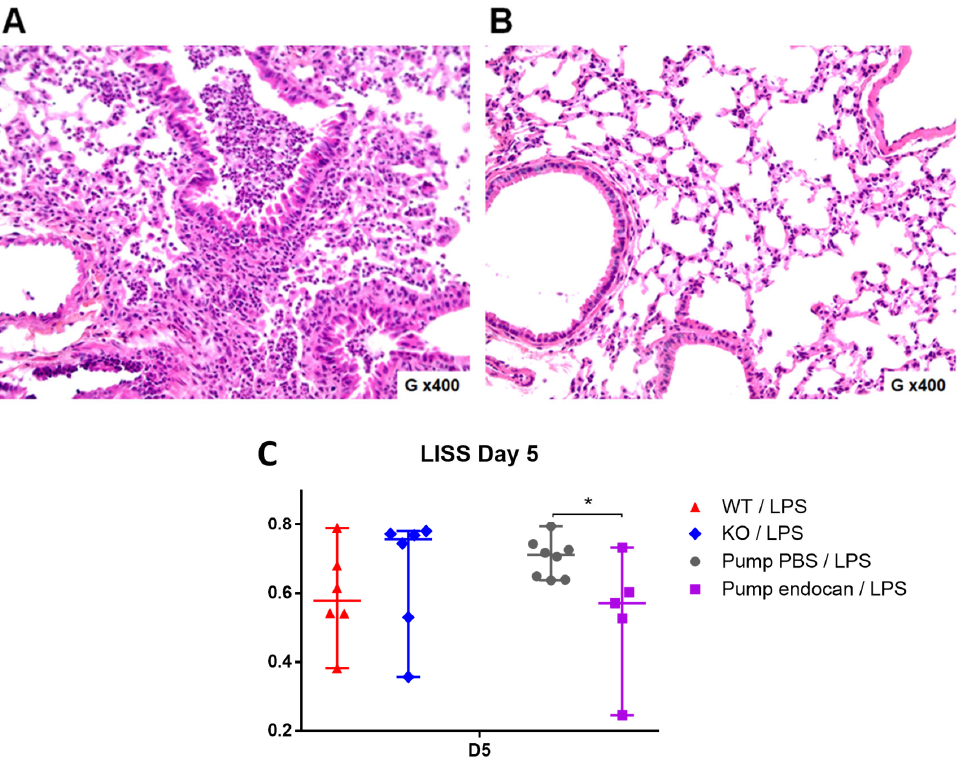
Figure 4. Continuous infusion of endocan alleviates the histological features of lung injury in Esm1 − / − mice. Histological examination of the lung and assessment with the lung injury severity score (LISS) at day 5 after intratracheal instillation of LPS in Esm1 − / − mice treated over 3 days by continuous infusion of PBS vs. murine endocan ( A , 200×; B, 200×). ( A ), we present the histological photography of an Esm1 − / − mouse treated with a continuous infusion of PBS. We can observe patchy neutrophilic infiltrates, hyalines membranes, and fibrin. ( B ), the histological photography of an Esm1 − / − mouse treated with a continuous infusion of murine endocan is shown. ( C ), we present the results of LISS between the WT (red) and the Esm1 − / − (blue) groups and between the Esm1 − / − group treated either with PBS (grey) or endocan (purple). Data are represented by their median, 25th, and 75th percen ‐ tile. * represents p < 0.05 as the result of the Mann–Whitney test between the variables of each group.